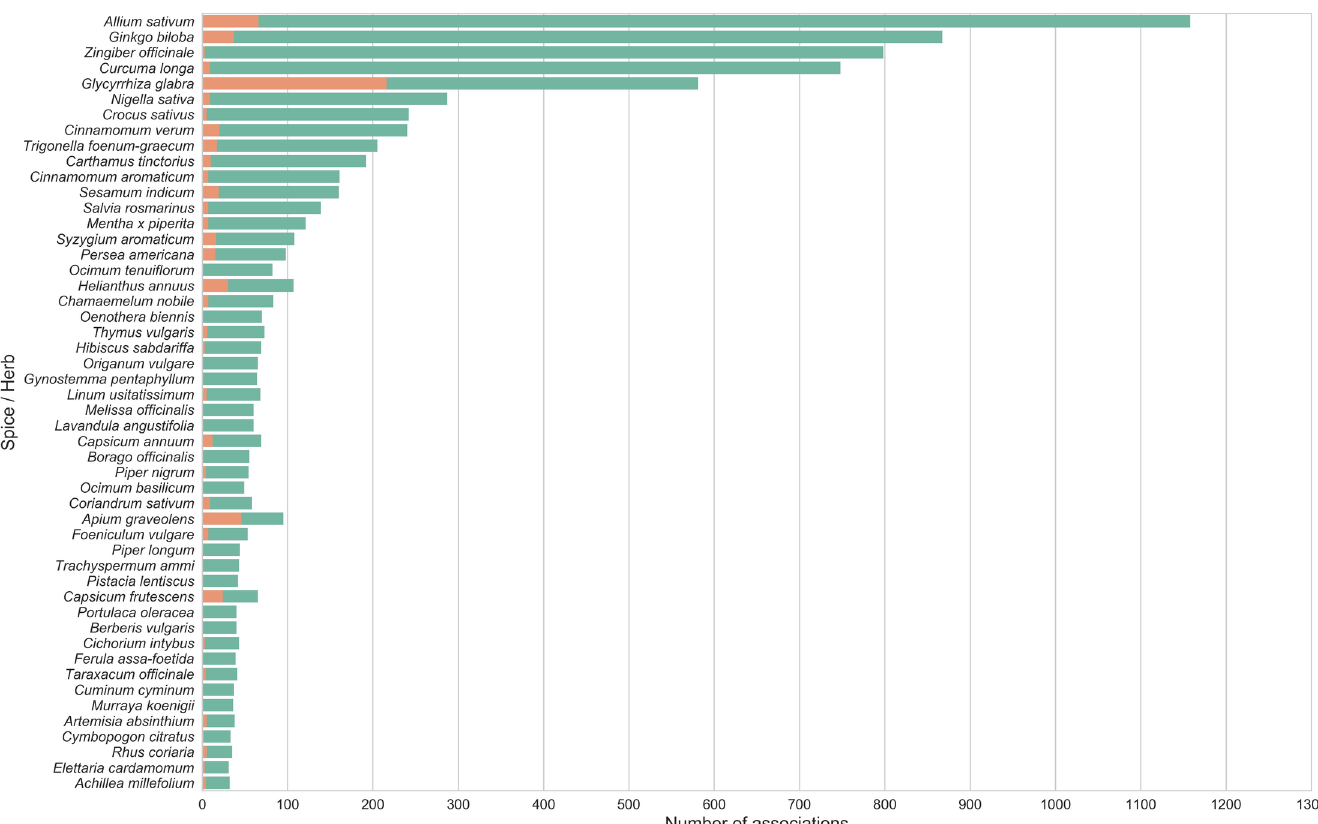
Fig 3. Statistics of positive and negative disease associations for the top 50 spices with most number of associations. Notice that certain spices like liquorice ( Glycyrrhizaglabra ) and celery (Apium graveolens ) had equal number of positive as well as negative associations. The bias in number of associations may also indicate the inherent biases in scientific literature suggesting that certain spices are studied more than